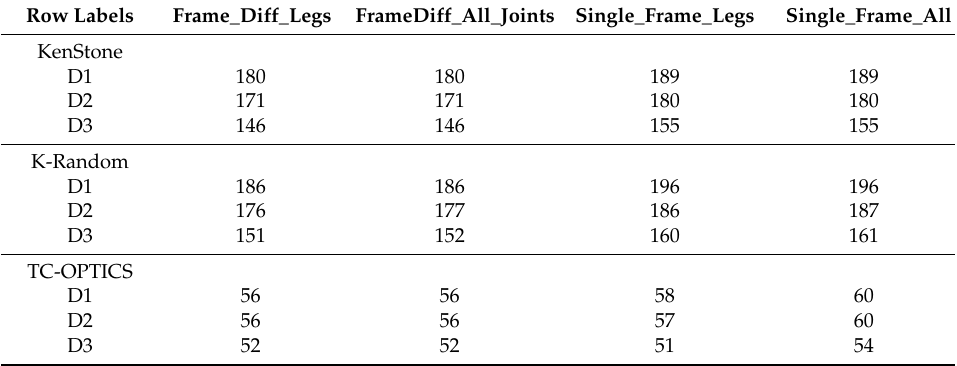
Table 2. Number of training samples, depending on the dancer and the sampling algorithm.